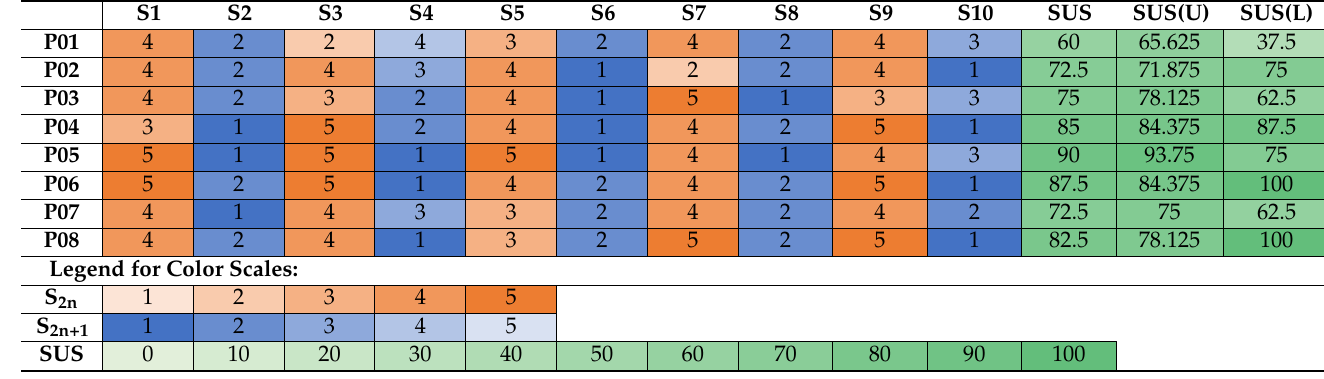
Table A3. Results of the application of the SUS questionnaire to eight physiotherapists at T1.